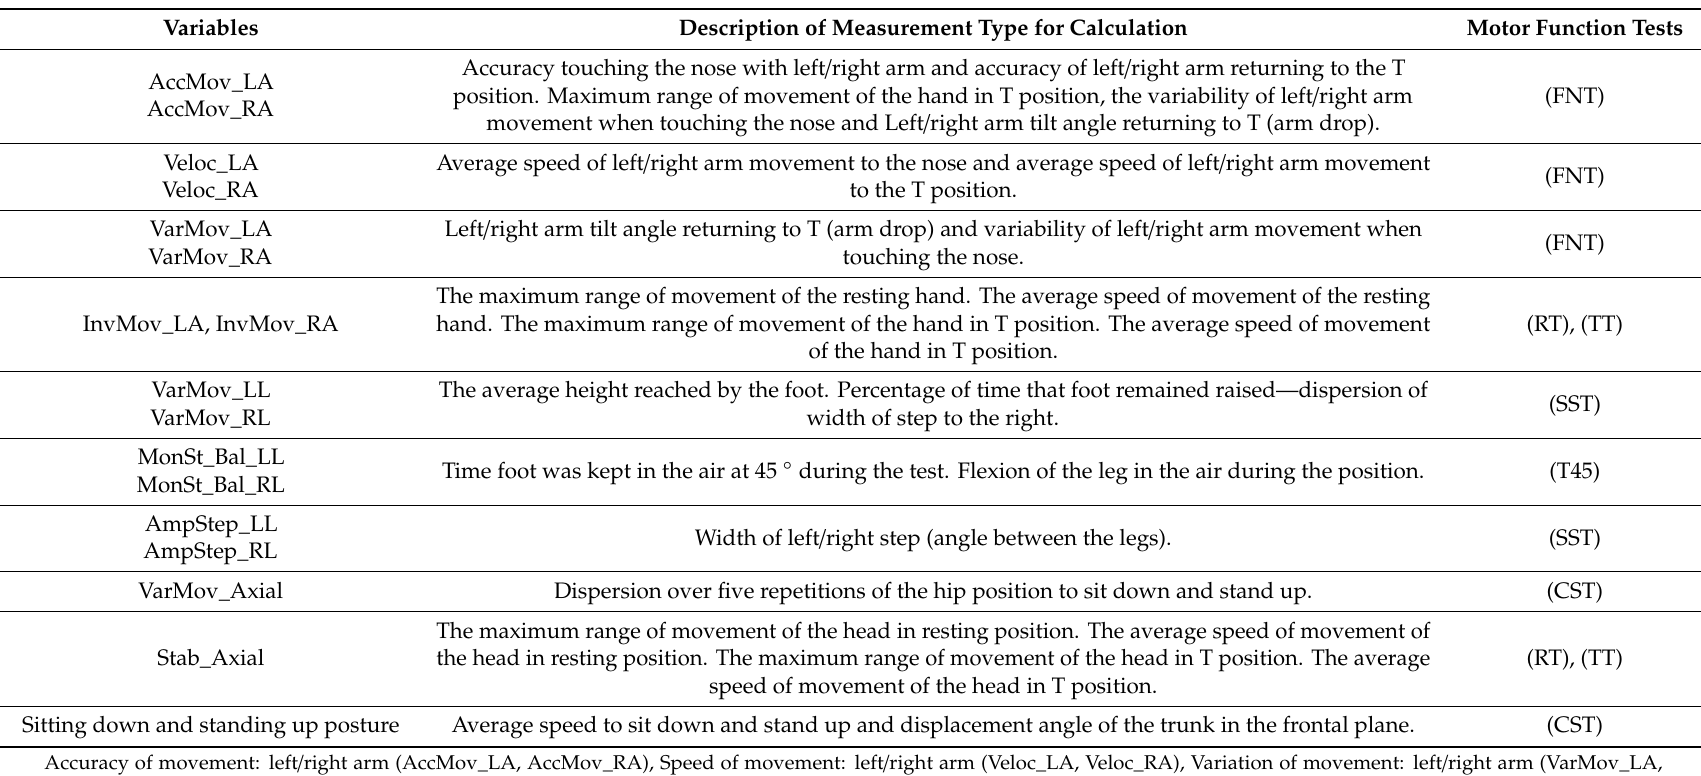
Table 1. Motor function tests: movement parameters